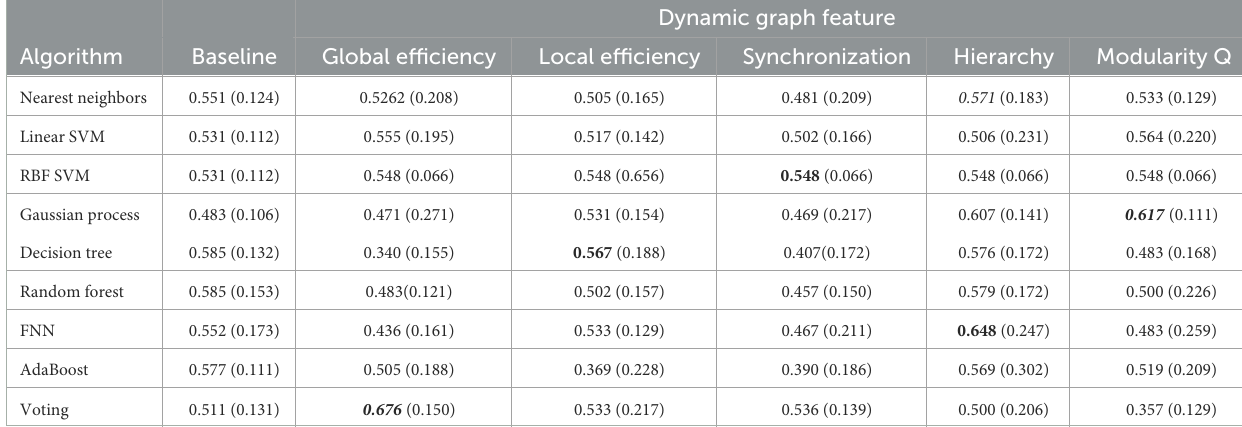
TABLE 5 The prediction accuracy of multiple machine learning algorithms with dynamic graph features (I).